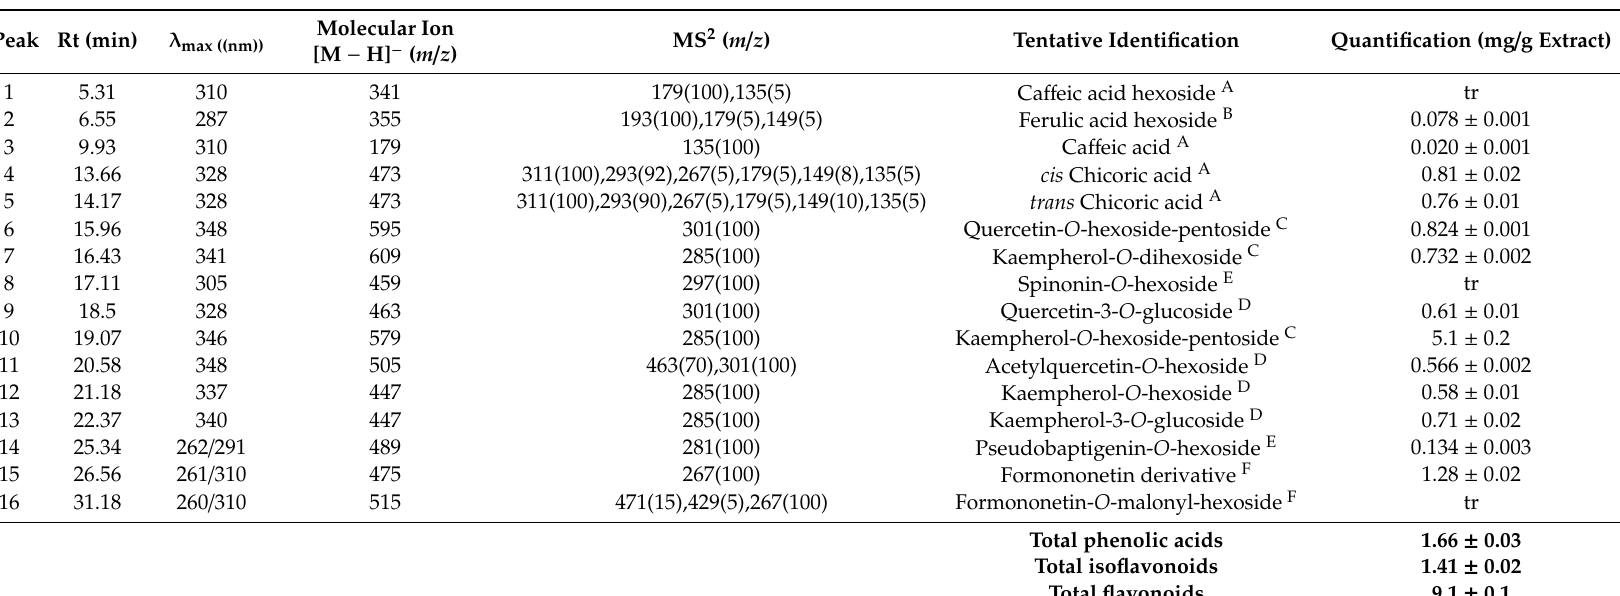
Table 1. Retention time (Rt), wavelengths of maximum absorption in the visible region ( λ max ), mass spectral data and tentative identification of the phenolic compounds present in Ononis spinosa